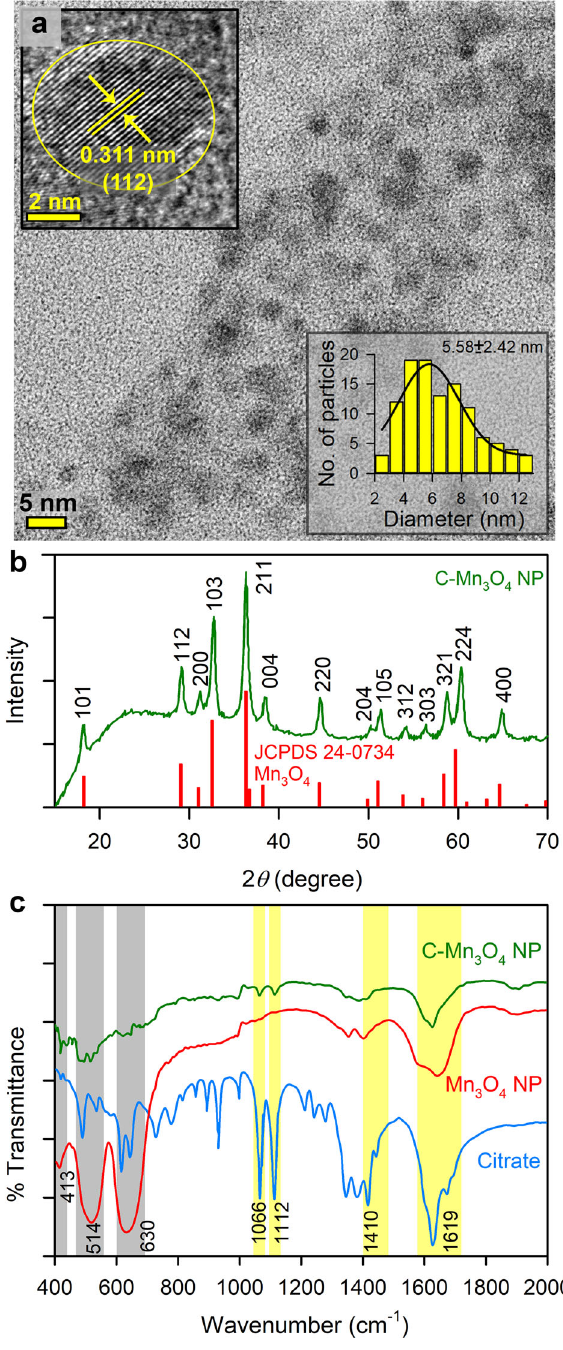
Fig. 1 Characterization of C-Mn 3 O 4 NPs. a TEM image of C-Mn 3 O 4 NPs shows the spherical shape of the nanoparticles with the monomodal distribution. Inset shows an HRTEM image of a single nanoparticle having a high crystalline structure with 0.311 nm interfringe distance corresponding to the (112) plane. The other inset shows the histogram for the size distribution of the nanoparticles having an average diameter of 5.58 ± 2.42 nm. b Experimental XRD peaks of the nanoparticle exactly match that of Mn 3 O 4 hausmannite de fi ned in the literature (JCPDS No. 24-0734). c FTIR spectra of C-Mn 3 O 4 NPs, Mn 3 O 4 NPs, and citrate. Perturbation at Mn – O stretching at 413, 514, 630 cm − 1 (shaded gray) of Mn 3 O 4 NPs and carboxylic groups at 1066, 1112, 1410, 1619 cm − 1 (shaded yellow) of citrate con fi rms strong covalent binding between citrate and the